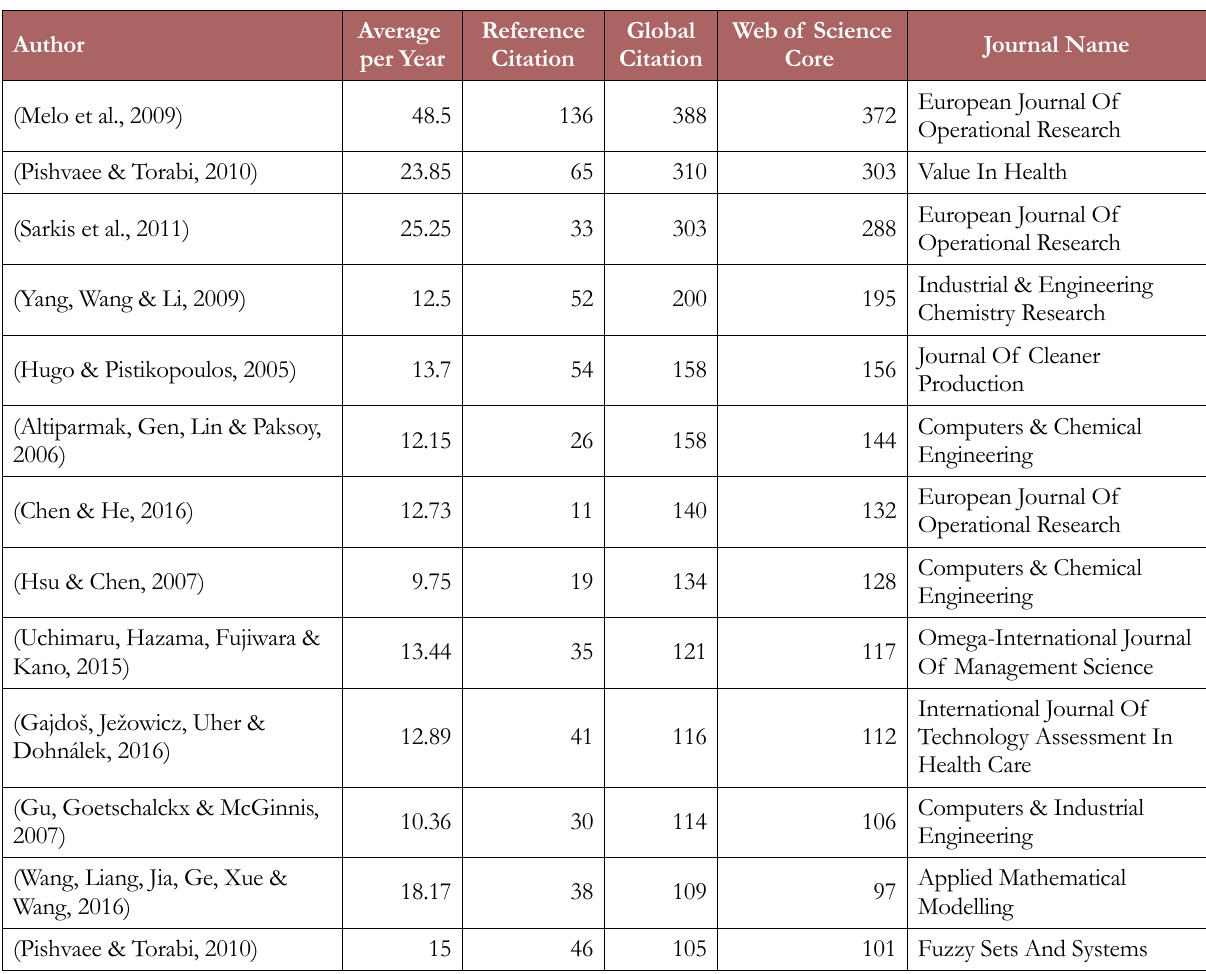
Table 9. Top authors with more global citation in Web of Science Core